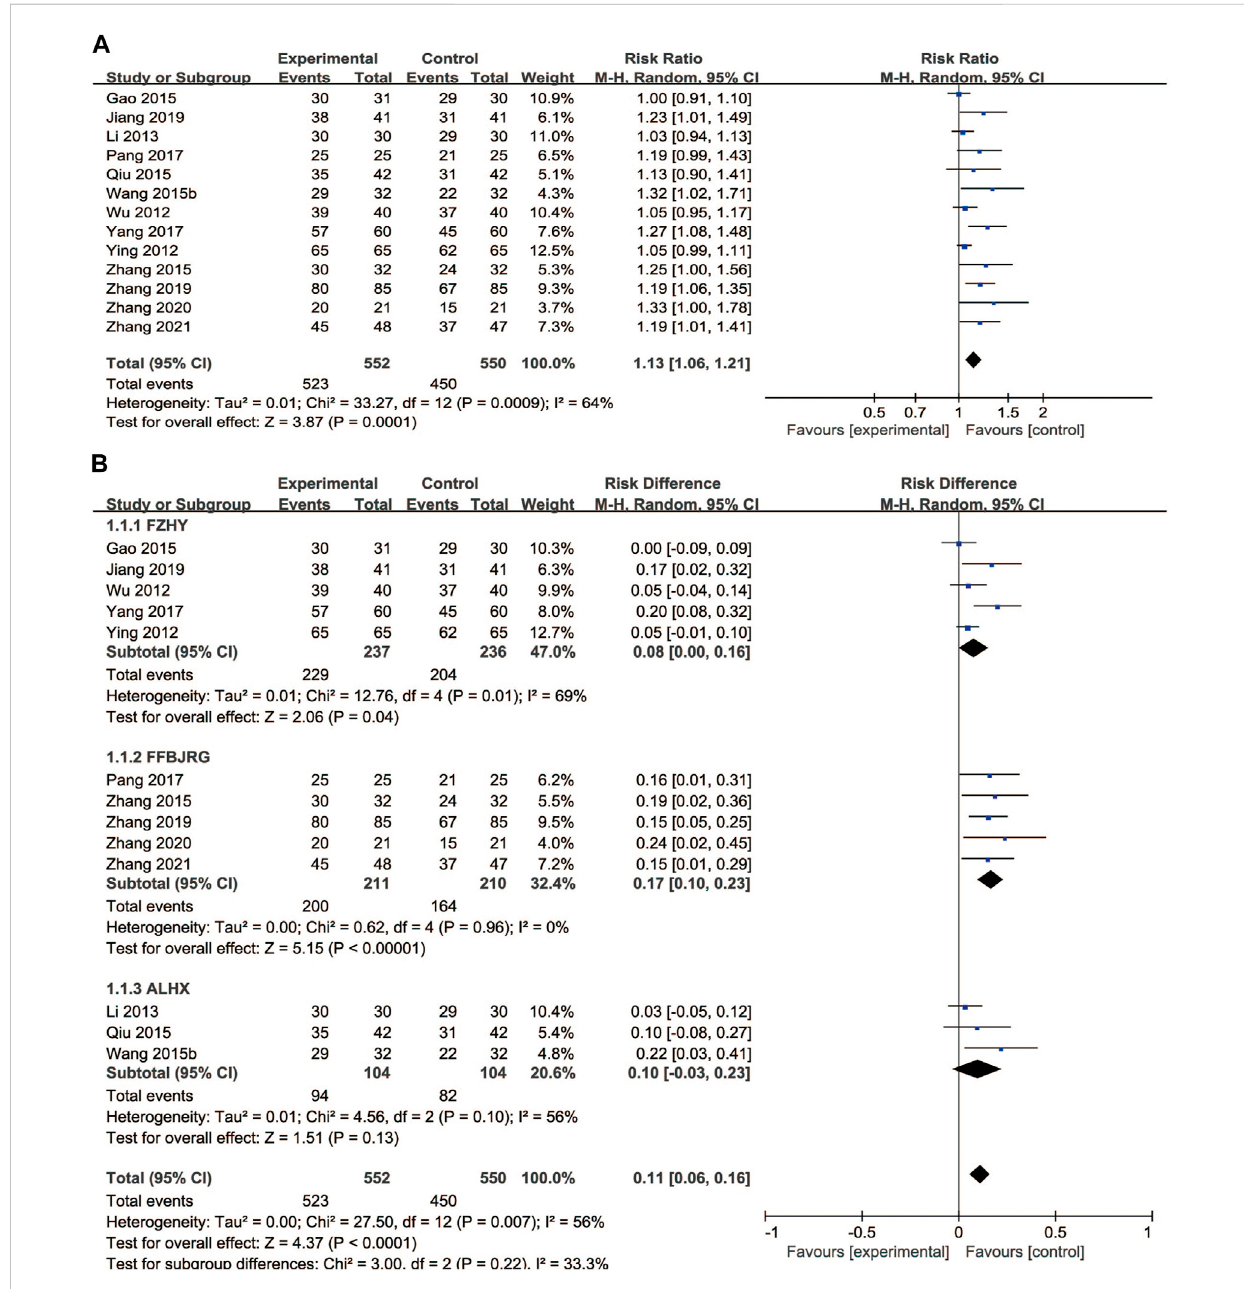
FIGURE 4 Forest plot of the meta-analysis (A) and subgroup analysis (B) of clinical ef fi cacy rate.